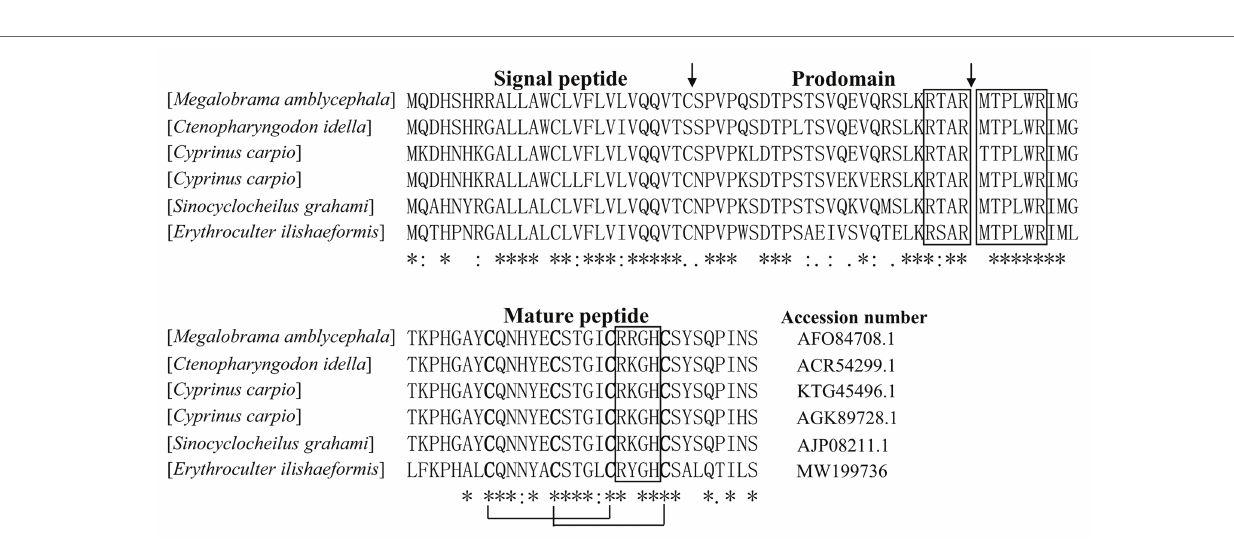
FIGURE 2 | The nucleotide sequence encoding topmouth culter LEAP-2 precursor. The amino acids of signal peptide are italic, the amino acids of prodomain are bold, and the amino acids of mature peptide are underlined. Line segment ( − ) indicates stop codon. The putative polyadenylation site (aataa) is boxed.